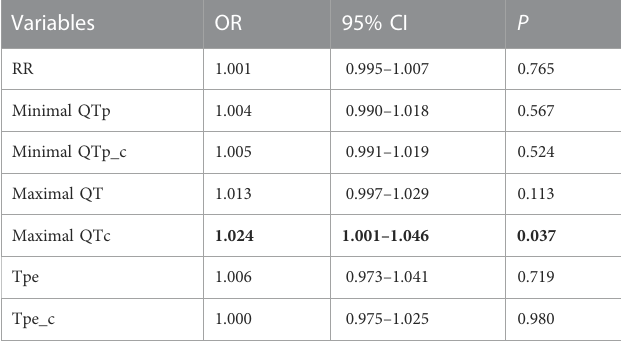
TABLE 3 Association between VF incidence and ECG parameters re fl ecting longest andshortestdurationsofrepolarization,cardiac cycle length andDOR in univariate logistic regression analysis (period 1 – 10 min of coronary occlusion).